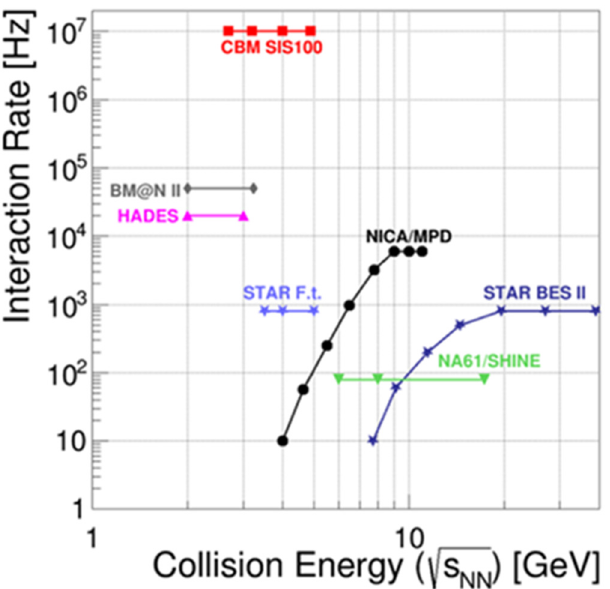
Figure 3. Interaction rates versus Au + Au collision energies for existing and emerging experiments (see text, taken from [5]).